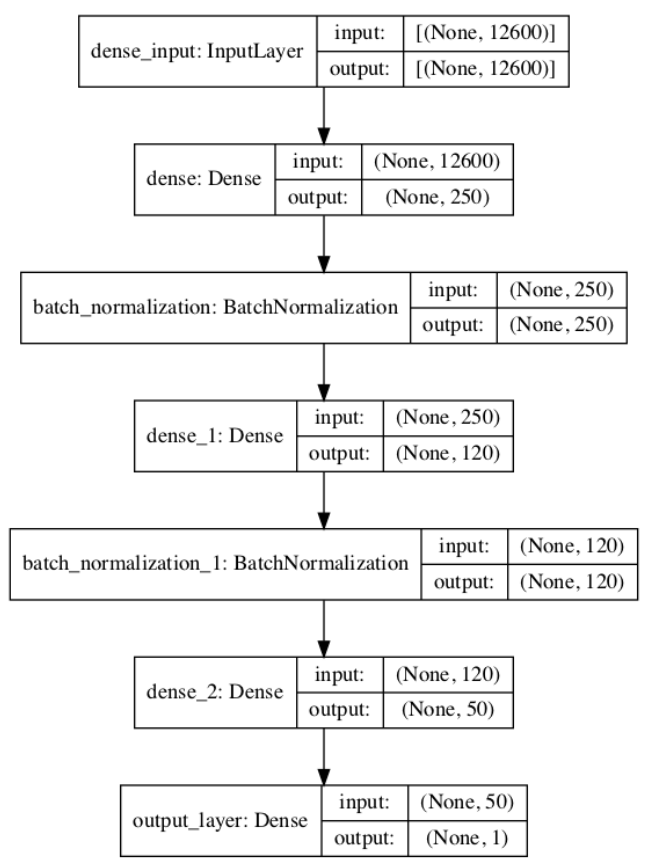
Figure 3. Example of 3 Dense-BatchNormalization neural networks used for detecting data hidden by a JPEG-based steganographic